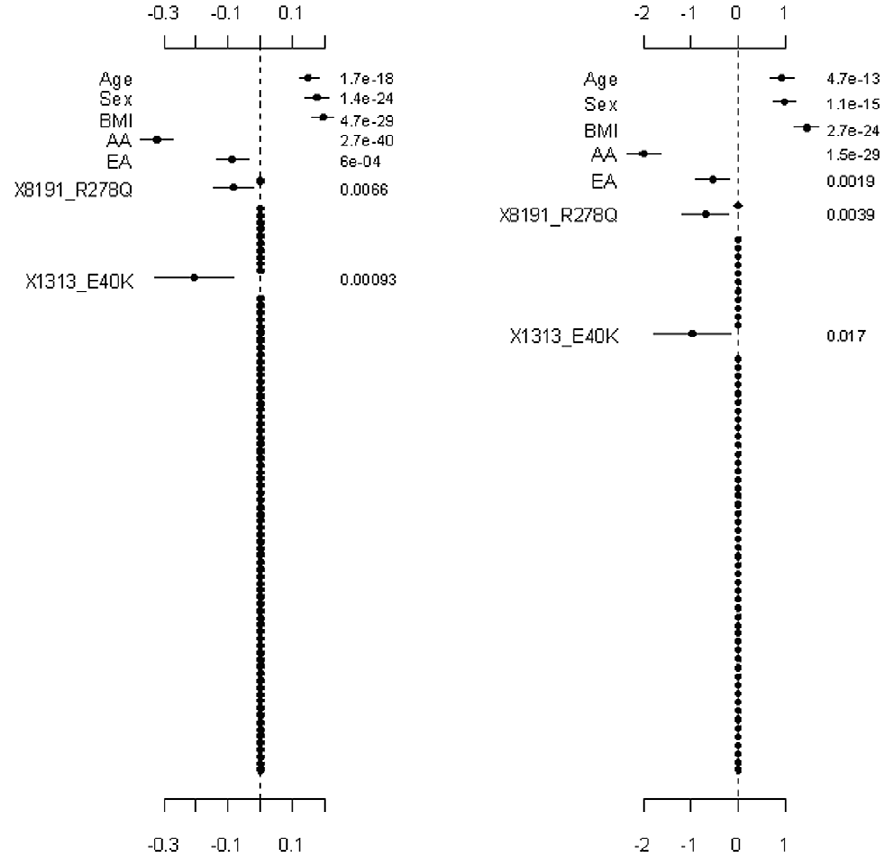
Figure 6. Ignoring the group effects and directly estimating the main effects of individual variants. The left and right panels are for the continuous and binary traits, respectively. The points, short lines and numbers at the right side represent estimates of effects, 6 2 standard errors, and p -values, respectively. Only main effects with p -value , 0.1 are labeled.